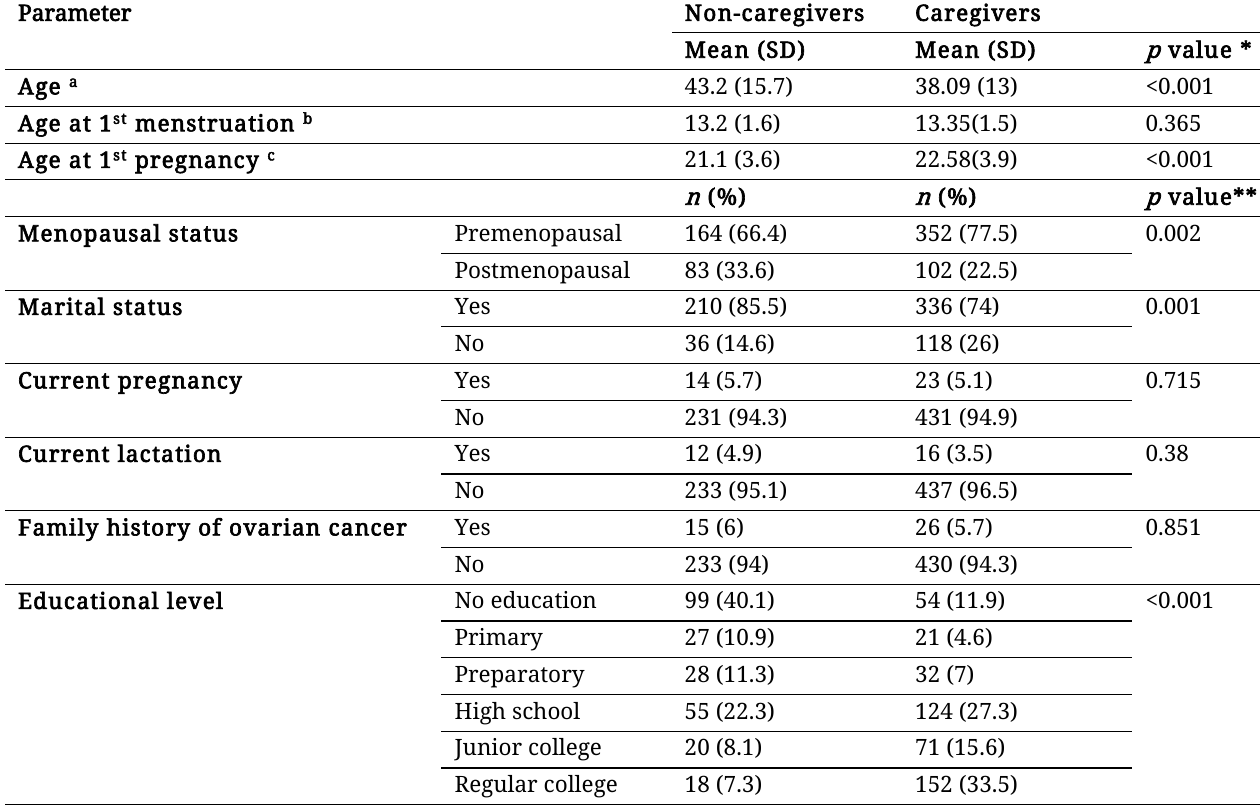
Table 1: Socio-demographic data of participants